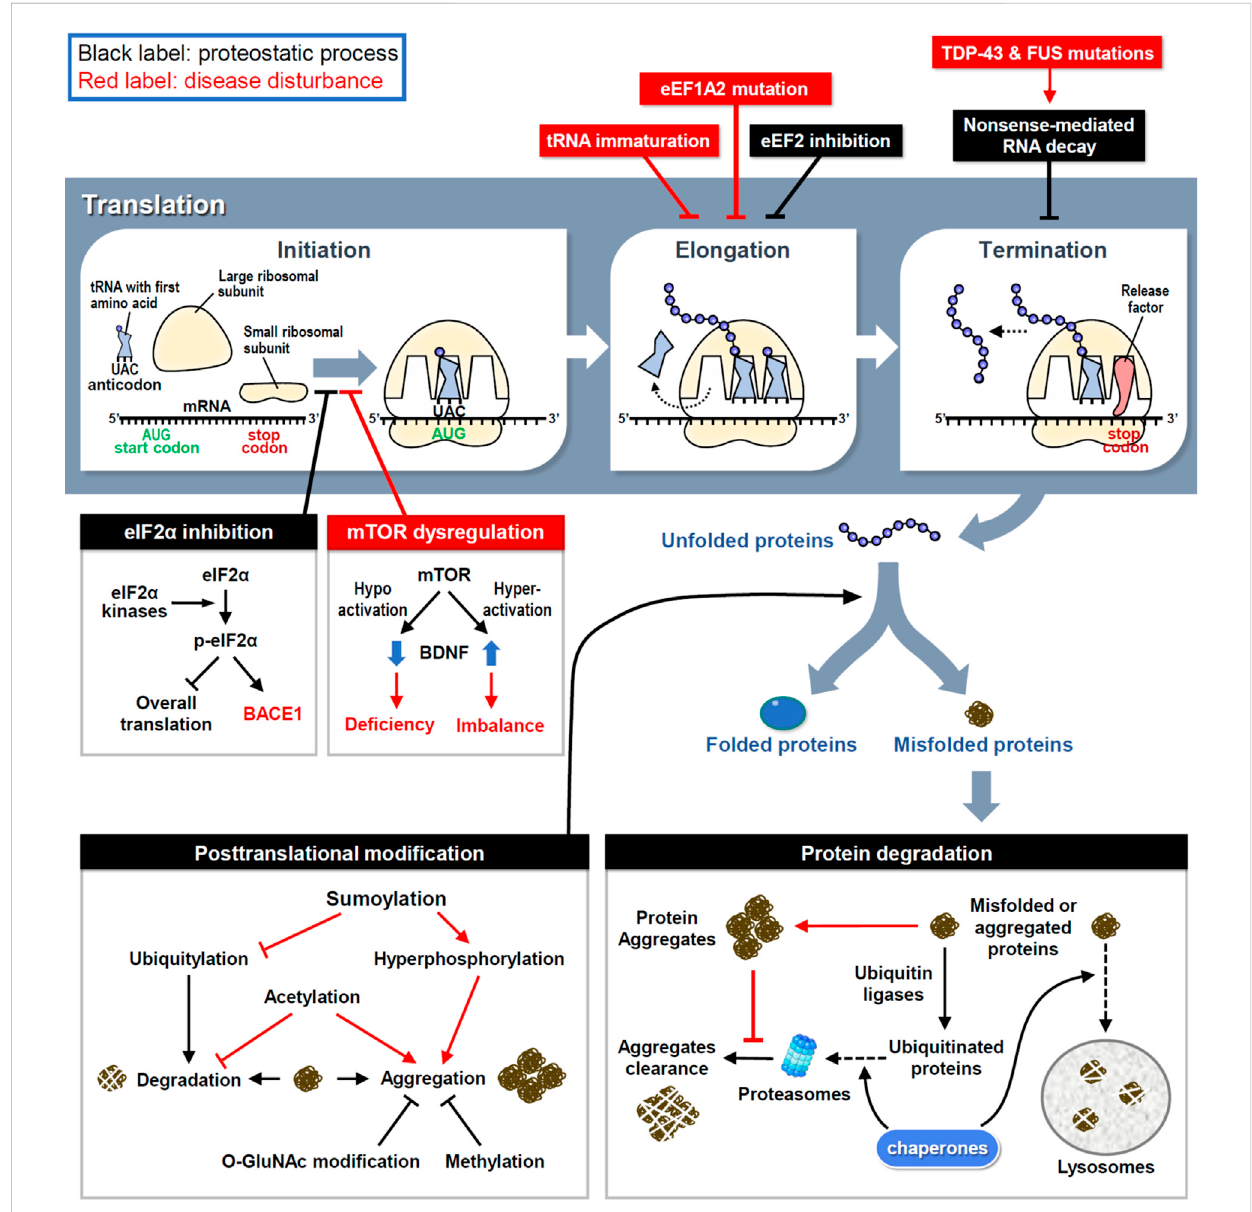
FIGURE 1 The proteostasis network and disease disturbances. RNA translation is divided into three steps and controlled by proteostatic processes. Under cellular stress, the assembly of initiation and elongation complexes is inhibited to reduce protein synthesis. Moreover, the premature transcript is degraded by NMD to avoid the generation of aberrant proteins. Mutations in key factors involved in translational procedures induce proteome stress and cause neuronal disorders. Following synthesis, nascent proteins experience posttranslational modi fi cations to achieve their correct folding and become functional. However, misfolded proteins are generated by proteome stress and eliminated by three types of protein degradation mechanisms. Under neuropathies, improper modi fi cations and resistances to degradation attenuate the clearance of misfolded proteins and fi nally cause the protein